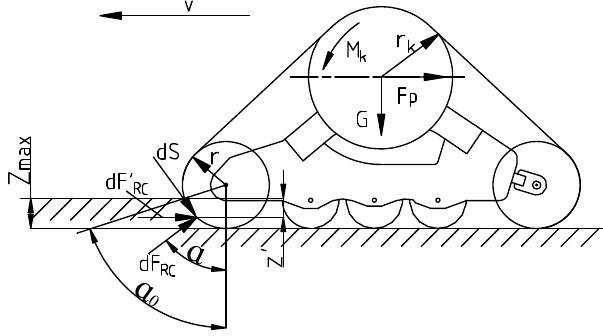
Figure 3. Interaction between track guide wheel and soil.